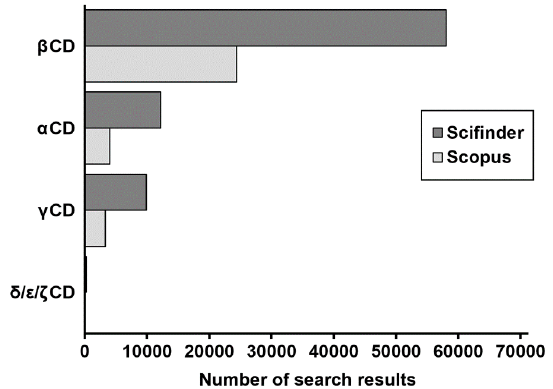
Figure 6. Number of search results obtained using as keyword the generic names of the most common CDs. Data collected from web search engines Scifinder (dark grey) and Scopus (light grey).